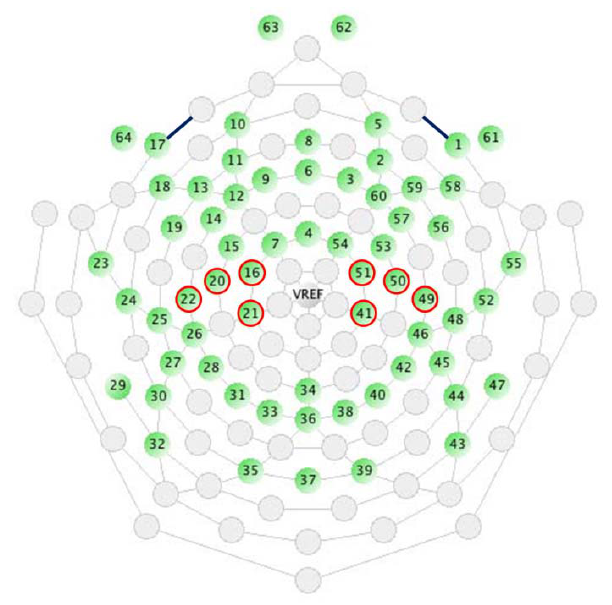
Figure 2. Two regions of interest (ROIs) were defined and respective electrode sites were pooled: left central (16, 20, 21, 22) and right central (41, 49, 50, 51).